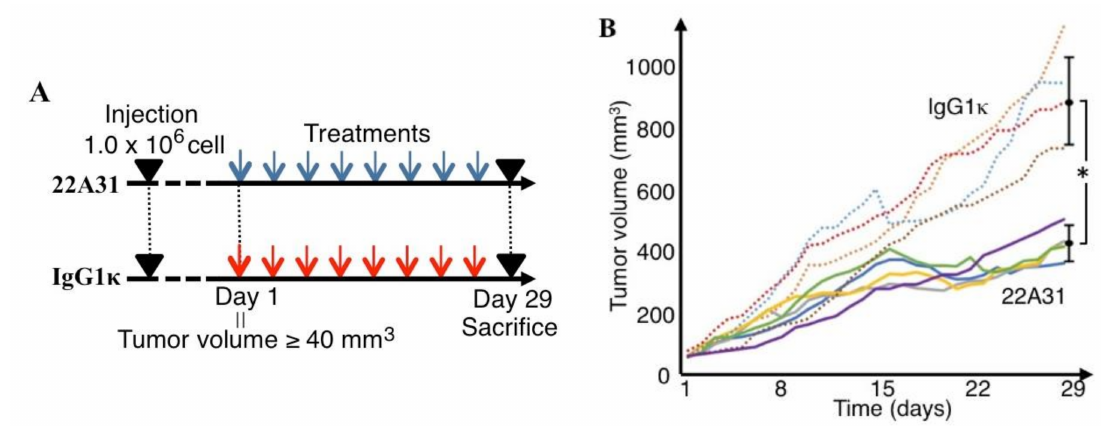
Figure 2. Anti-tumor activity of 22A31 in HCT116 human colorectal adenocarcinoma cells. ( A ) Ex- perimental protocol. Day 1 was defined as when the tumor volume was over 40 mm 3 . All mice were treated eight times with 200 µ g 22A31 or IgG1 κ (twice per week), and euthanized on Day 29. ( B ) Tumor volumes in 22A31 and IgG1 κ treatment groups. Solid lines and dashed lines represent the tumor volumes of 22A31 and IgG1 κ treatment groups respectively. The average tumor volume ± SD in each of 22A31 and IgG1 κ treatment groups on day 29 are shown. * p <